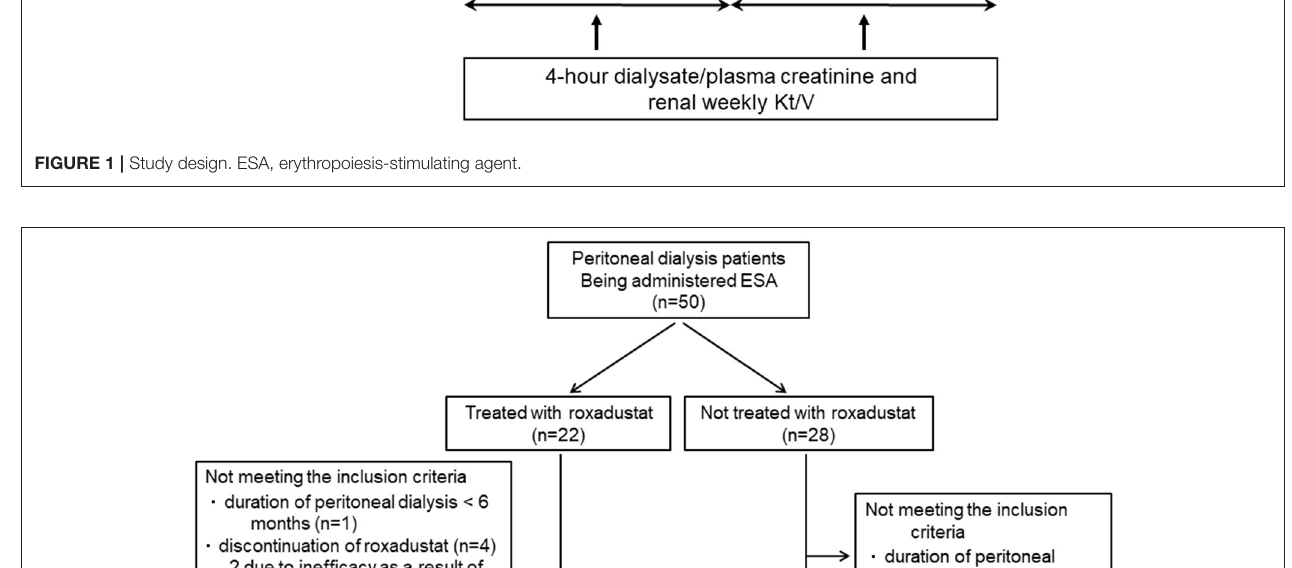
were analyzed. Their mean hemoglobin and ferritin concentrations and TSAT were 10.7 ± 1.3 g/dL, 166.1 ± 107.2 ng/mL, and 39.3 ± 12.3%, respectively. Twenty-two patients had been treated with darbepoetin alfa and 17 with epoetin beta pegol once per month. The mean ESA dose was 5,231 ± 2,319 IU/week